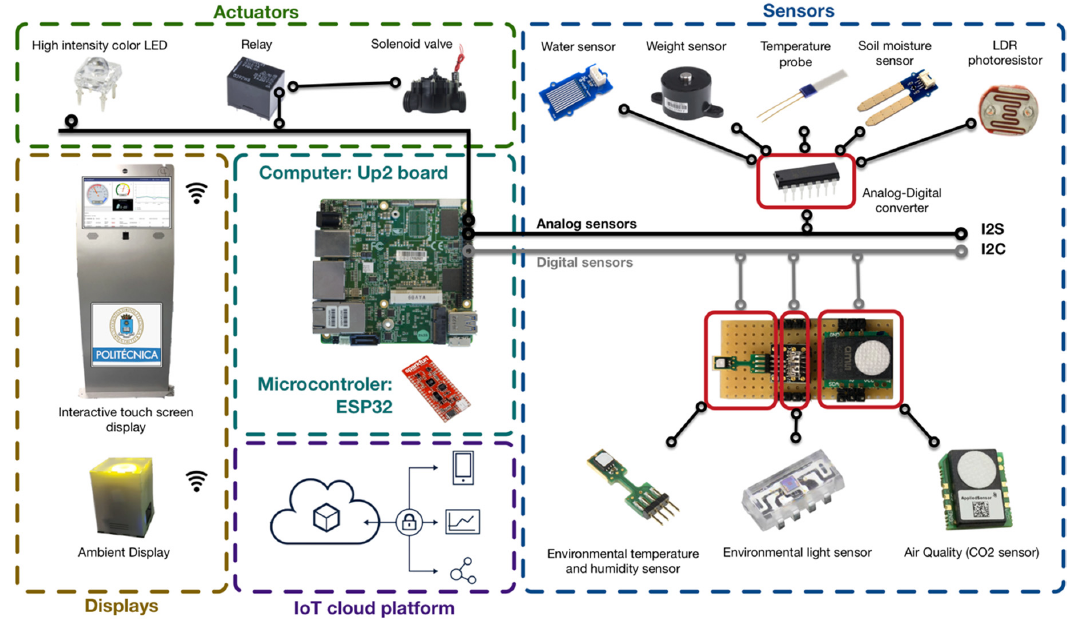
Figure 2. Holistic architecture of the components included in the IoT planters.